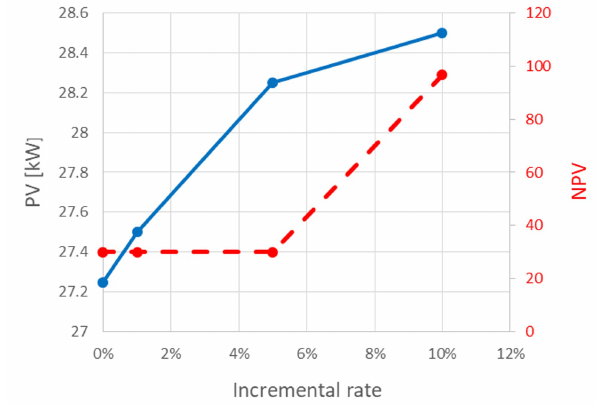
Figure 4. Optimal PV sizing with no BESS (principal axis) and corresponding NPV (secondary axis) as a function of demand growth